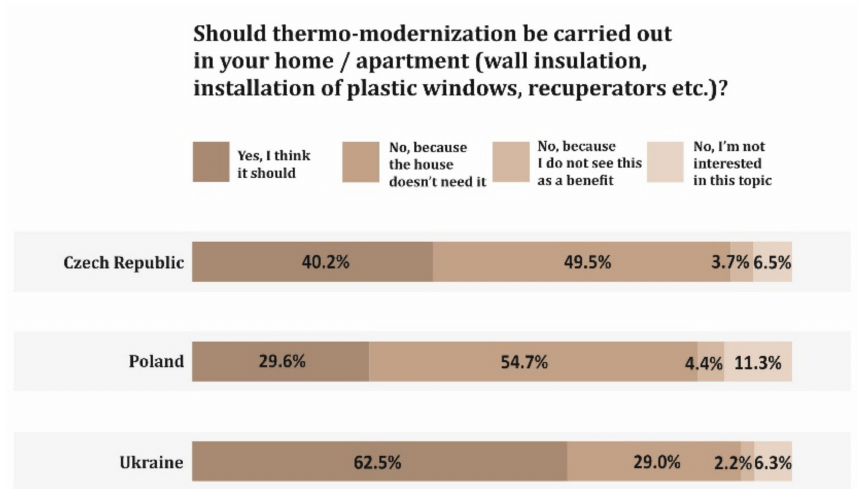
Figure 4. Distribution of responses on thermal renovation of the buildings in which the respondents reside. Source: own